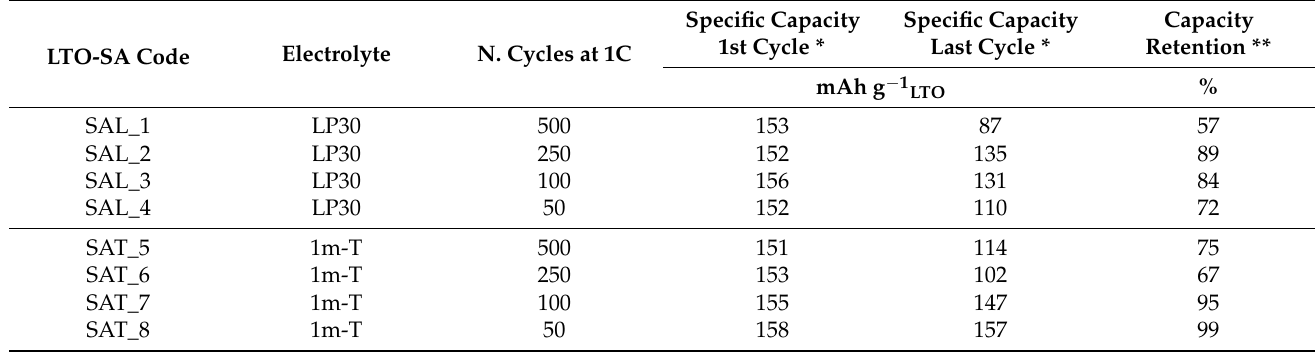
Figure 3. Specific capacity delivered during the lithiation (empty symbol) and de ‐ lithiation (full symbol) processes of LTO ‐ SA (black symbol) and LTO ‐ PVdF (red symbol) over 500 cycles at 1C in ( a ) 1m ‐ T and ( b ) LP30. Table 3. Specific capacity (mAh g − 1 LTO ) during de ‐ lithiation process at the first and last cycle at 1C and capacity retention of LTO ‐ SA tested in LP30 and 1m ‐ T.